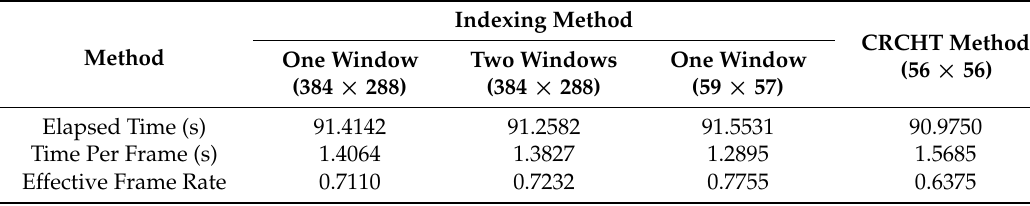
Table 7. Comparison of the processing speed for CRCHT and Indexing